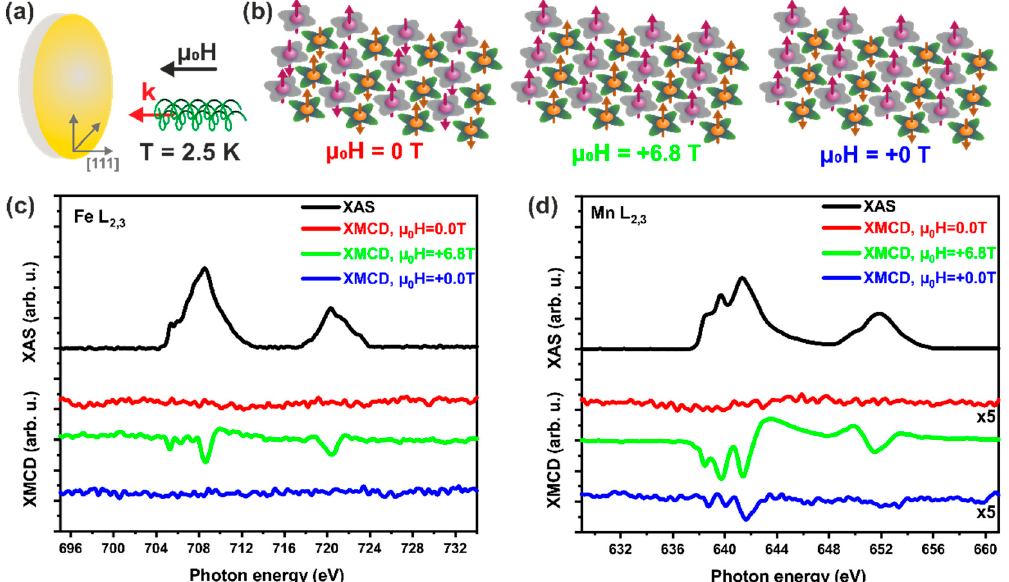
Figure 2. XMCD investigation of the magnetic properties of the binary MnPc+FeFPc/Au(111) system. ( a ) Sketch of the experimental set-up of the XAS/XMCD measurements in normal X-ray incidence: the external magnetic field and the k-vector of the X-rays are parallel to the surface normal along the crystallographic [111] direction. ( b ) Illustration of the initially disordered molecular spins at 0.0 T, the high field enforced, the parallel (ferromagnet-like) aligned spins at +6.8 T and the ferrimagnetically ordered spins at +0.0 T after initial magnetization. XAS (black) and XMCD L 2,3 spectra of Fe ( c ) and Mn ( d ) in chronological order acquired in normal X-ray incidence at 0.0 T (red), +6.8 T (green), and +0.0 T (blue). The XAS is plotted upon background subtraction. The XMCD spectra of Mn at 0.0 T (red) and +0.0 T (blue) are enhanced by a factor of 5 for better visibility. No XMCD was detected in the initial measurement at 0.0 T; it only appeared upon magnetization at +6.8 T. All experiments were performed at 2.5 K.